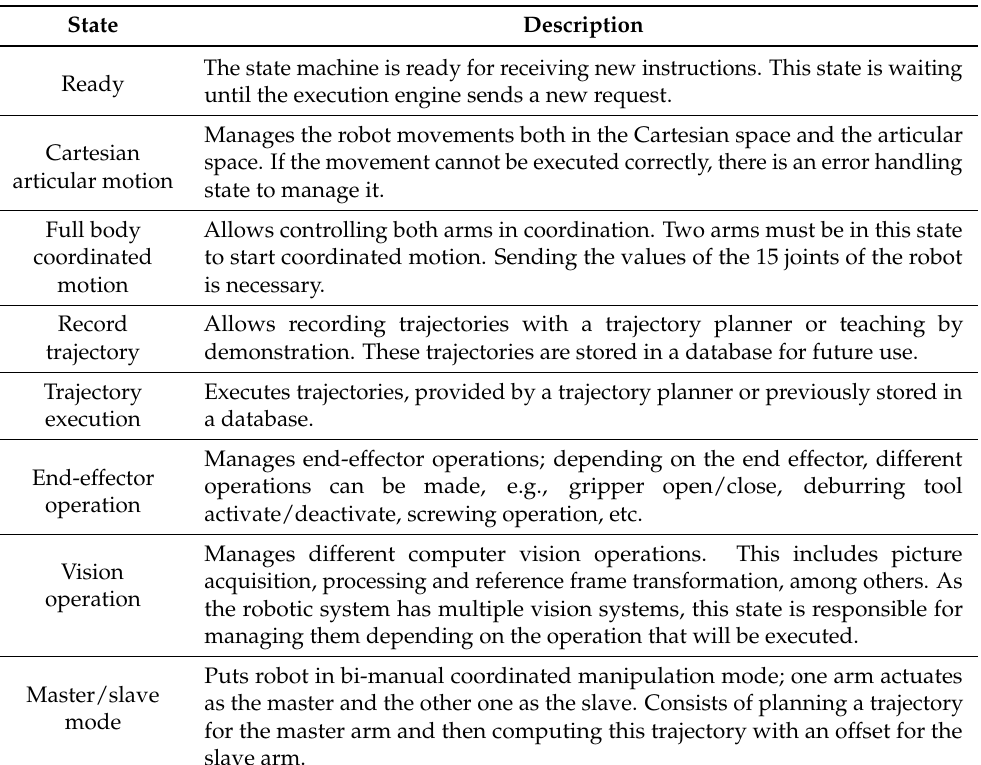
Table 1. Summary of the main elements of the state